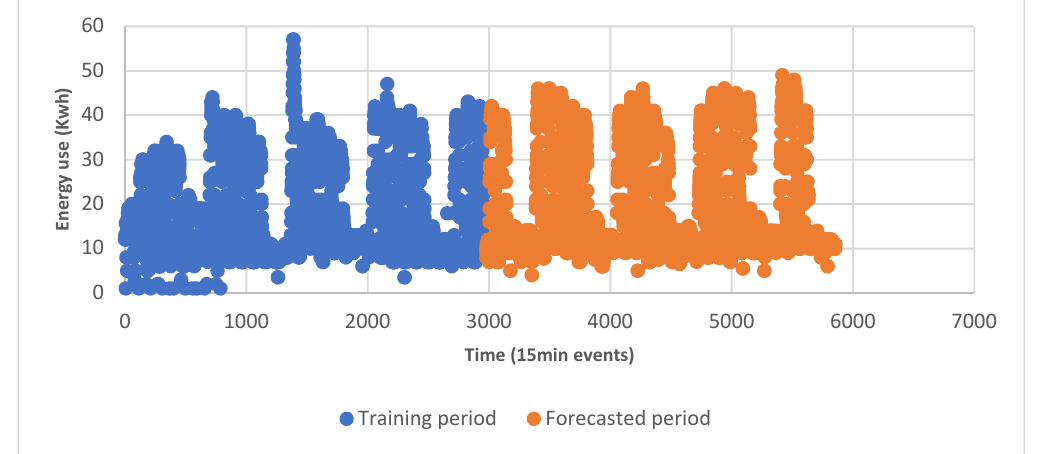
Figure A4. Building energy use over the winter training and testing period. Table A1. The impact of altering the number of neurons on the ANN monthly predictions’ RMSE and SE. Number of Neurons